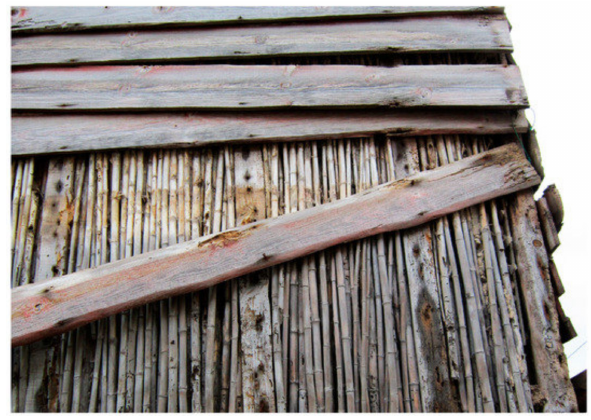
Figure 2. Use of reed for wall construction: palheiro in Leirosa